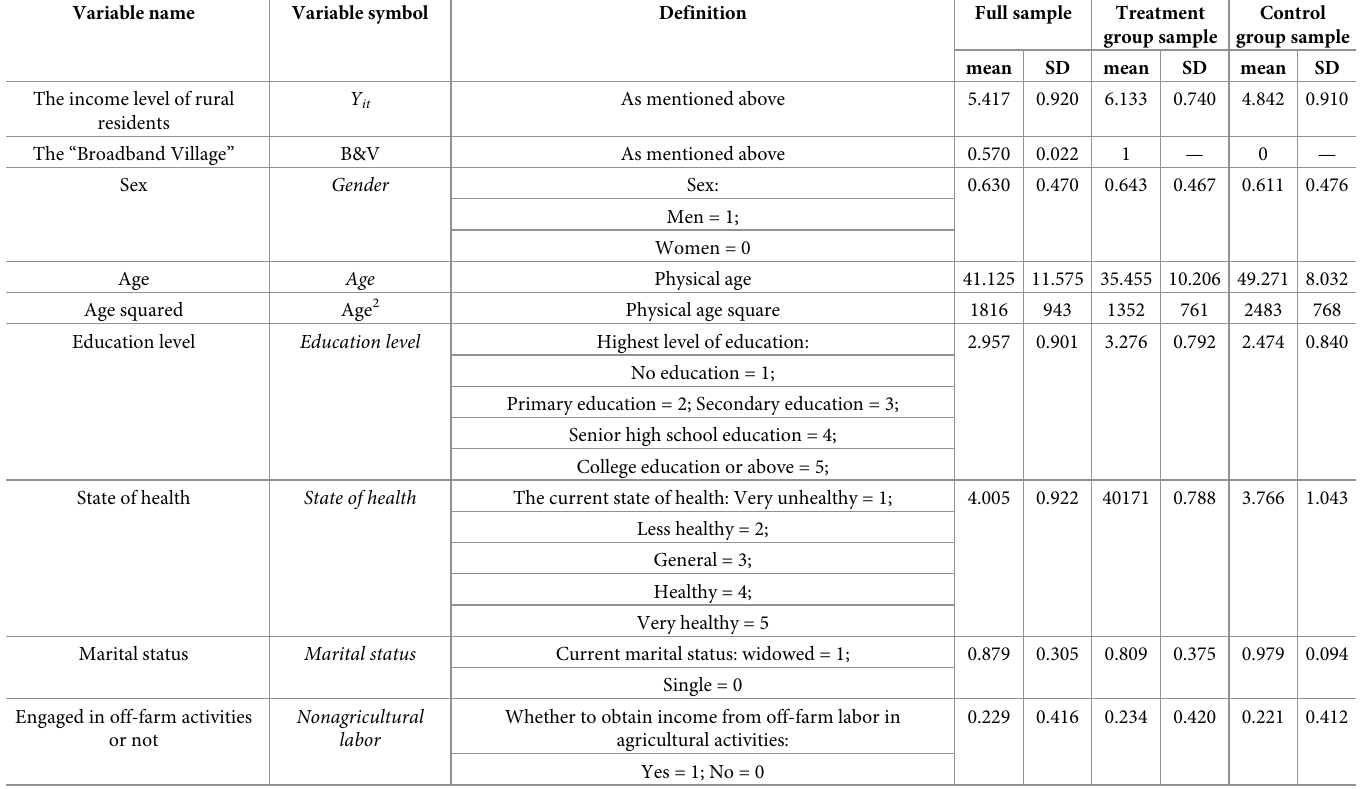
Table 1. Definition and descriptive statistical analysis of